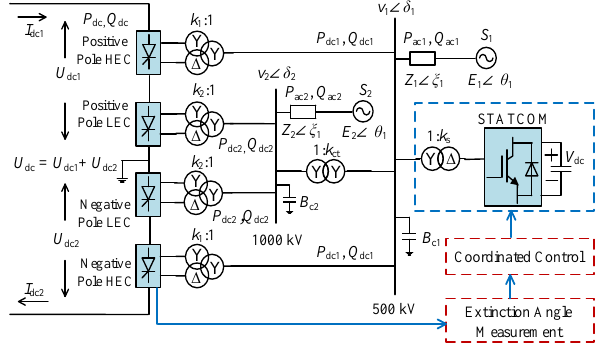
Figure 1. The basic structure of the inverter ‘ side of the UHVDC-HCS with STATCOM system.